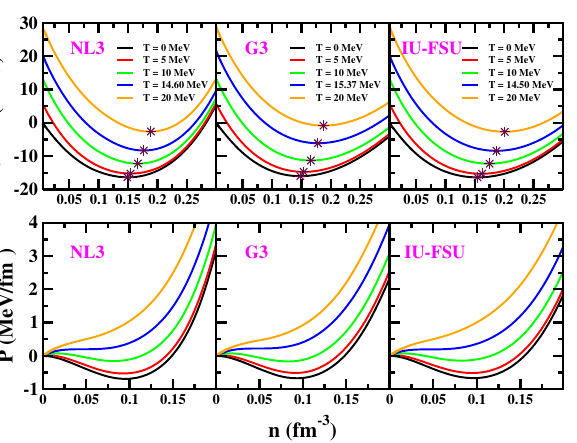
Fig. 2 Incompressibility ( K ) asafunctionofnucleondensityforSNM ( t = 0). The left panel shows the results for NL3, middle panel for G3 and right panel for IU-FSU parameter set effect of temperature on F sym and its first derivative L sym (i.e slope parameter) of SNM. Rise in temperature does not hint any significant change in the symmetry energy of the system at high density. However, the magnitude of the